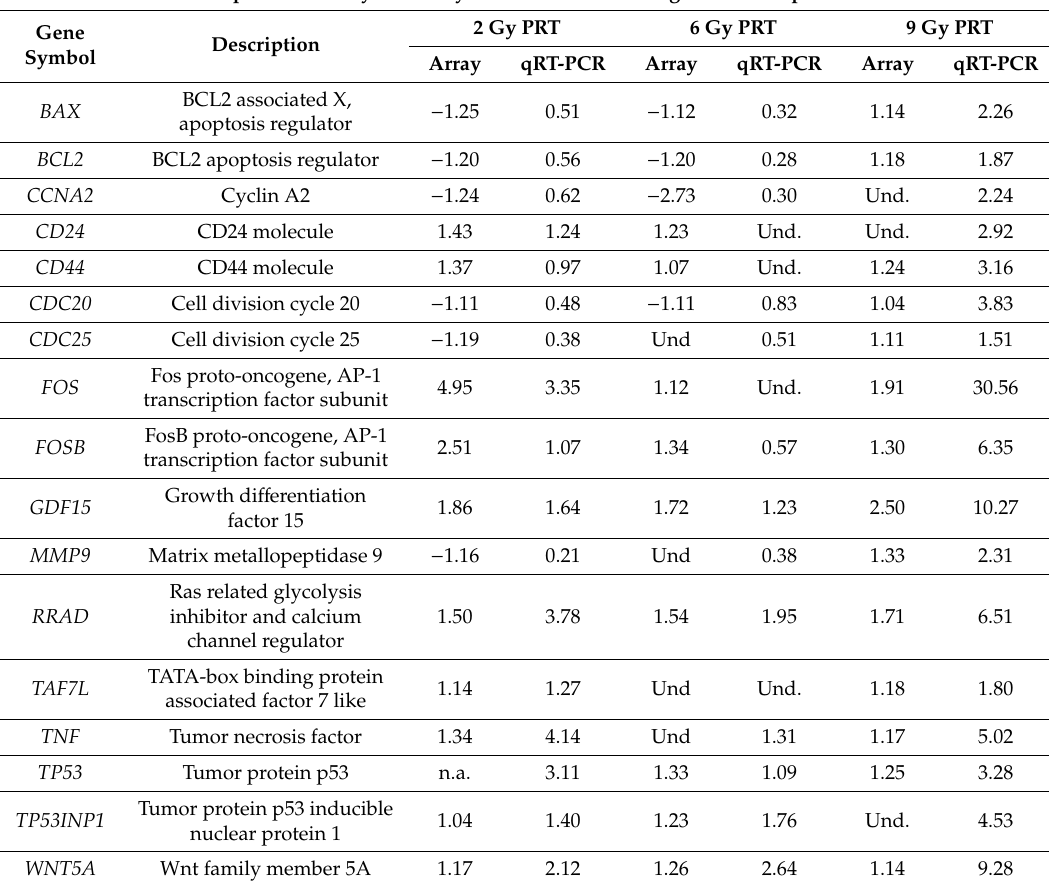
Table 5. Gene expression analyses of key genes of TNBC (triple-negative breast cancer) xenograft mice exposed to Proton RadioTherapy PRT. Gene Expression Analyses of Key Genes of TNBC Xenograft Mice Exposed to